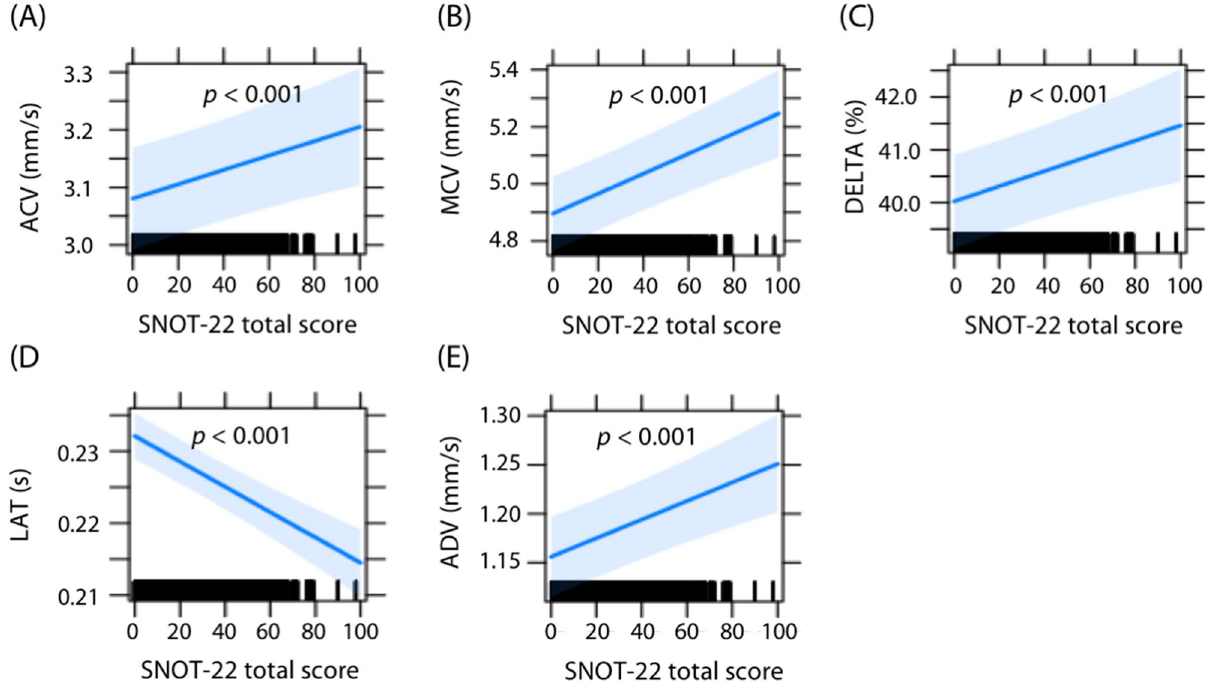
Figure 2. Association between SNOT-22 total symptom scores and pupillary light reflex parameters showing significant regression coefficients. The graph shows parameter slopes for changes in SNOT-22 total symptom scores with 95% confidence intervals. ( A ) ACV, ( B ) MCV, ( C ) DELTA, ( D ) LAT, and ( E ) ADV. ACV average constriction velocity, ADV average dilation velocity, DELTA constriction ratio, LAT constriction latency, MCV maximum constriction velocity, SNOT-22 22-item Sino-Nasal Outcome